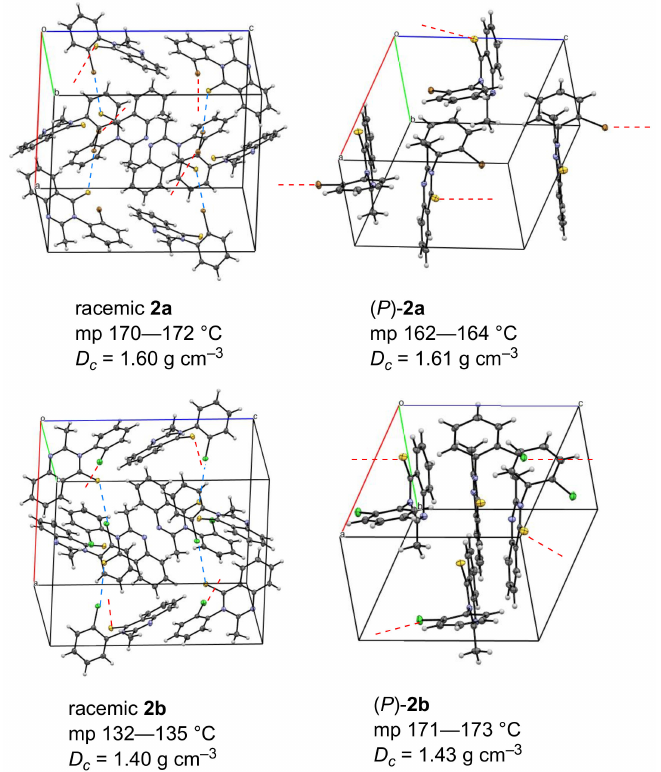
Figure 6. Packing structures of racemic 2a , b and ( P )- 2a , b